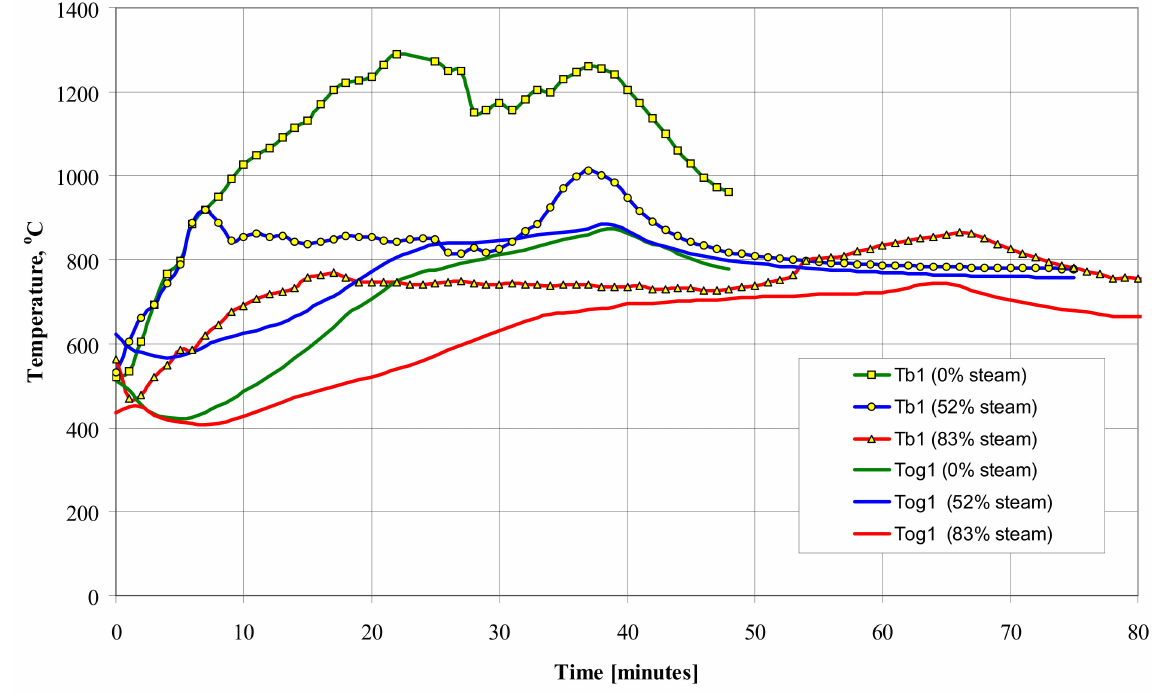
Figure 7. Influence of feed gas composition on T b1 and T og1 temperature values during gasification of wooden pellets. Increasing the proportion of water vapor in the feed gas causes an increase in the amount of hydrogen H 2 and a decrease in T b1 temperature due to the endothermic reaction with carbon C and carbon monoxide